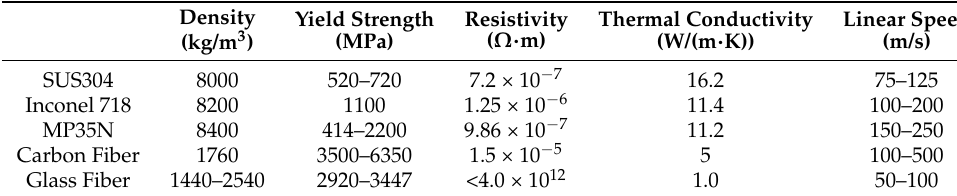
Table 1. Physical parameters of several rotor protection